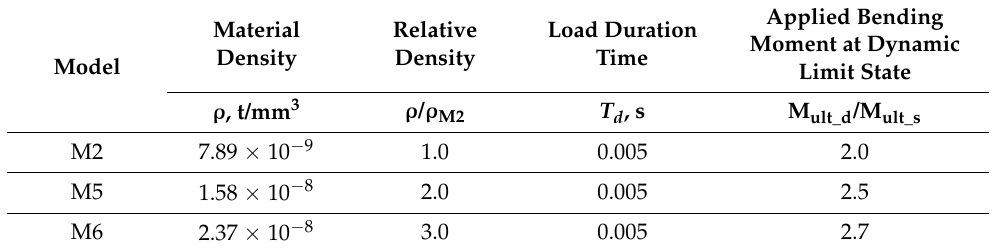
Table 6. Comparison of dynamic ultimate moment of box girder with various density.